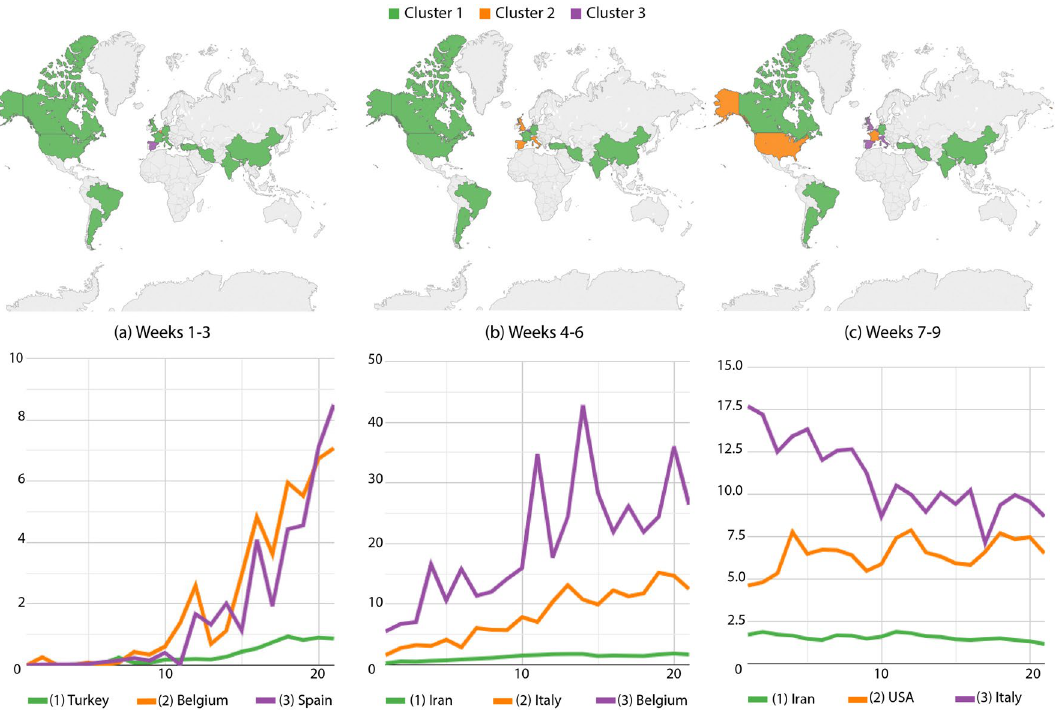
Figure 6. Death cases per million inhabitants: country partitions along weeks 1–9. Top images identify country groups and bottom curves correspond to the infection incidence levels: green, orange and purple correspondingly map the low, medium and high-incidence groups. Curve legends indicate the group descriptor. Top-most maps were generated by using Tableau Desktop-Professional Edition (https:// www. table au. com/, version 20181.20.0213.2110-64 bit), and bottom-most charts were generated by using Google Charts (https:// devel opers. google. com/ chart, version